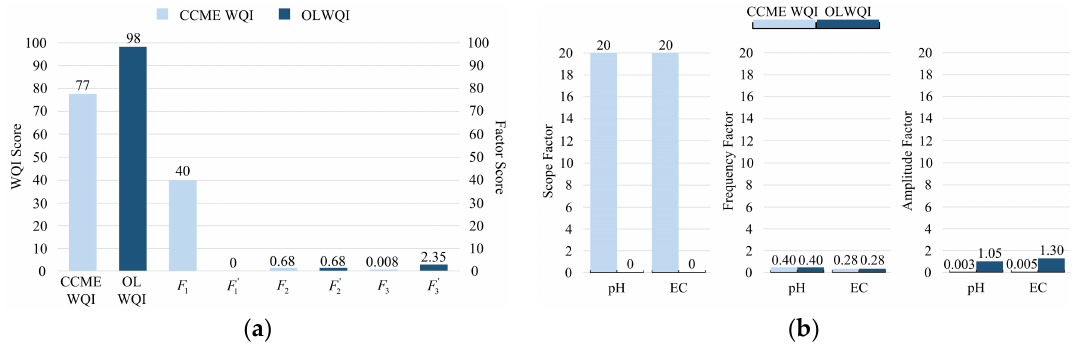
Figure 9. Comparison of the CCME WQI and the OLWQI: ( a ) Quality indexing results; ( b ) Factor scores due to the failed tests.